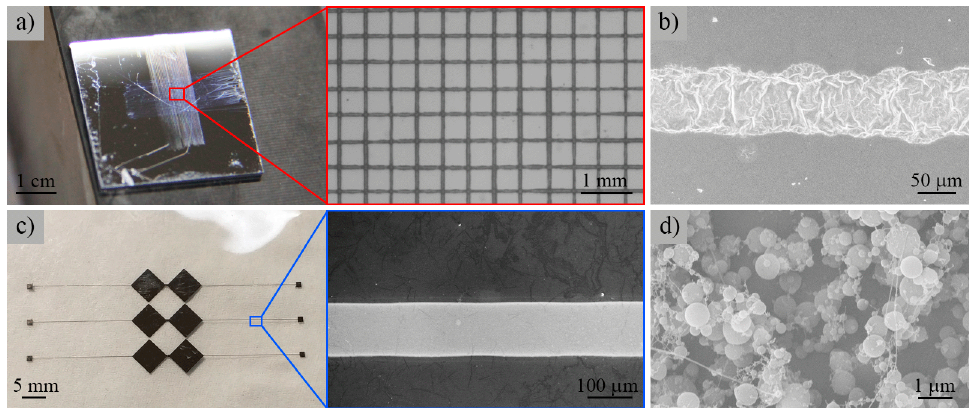
Figure 11. Various electrosprayed patterns. ( a ) ZnAc grid patterns deposited on a silicon substrate. ( b ) ZnO pattern generated by calcining the as-prepared ZnAc in air at 773 K for 30 min. ( c ) Silver pattern deposited on a glass substrate. ( d ) Chitosan nanoparticles electrosprayed on aluminum foil.